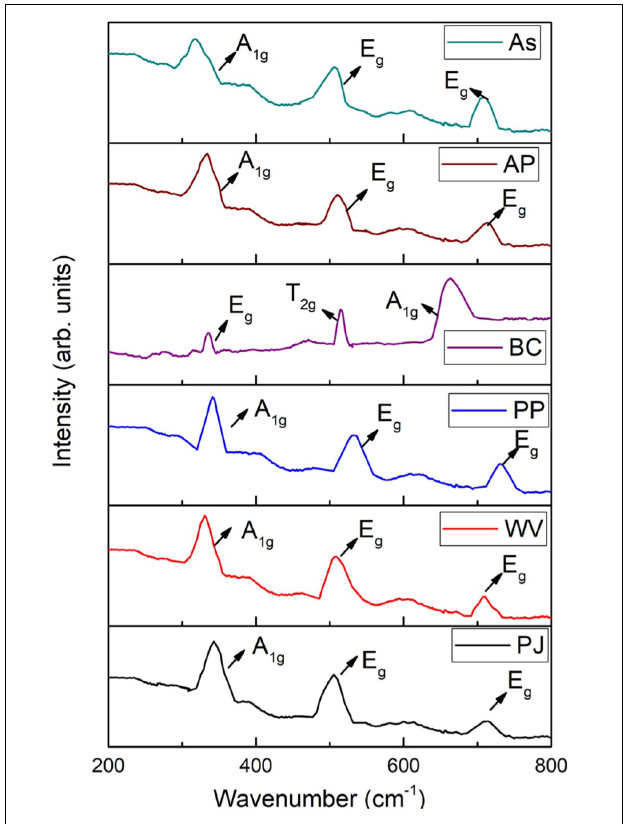
FIGURE 9 | Raman spectra of iron oxide nanoparticles (IONPs) using various